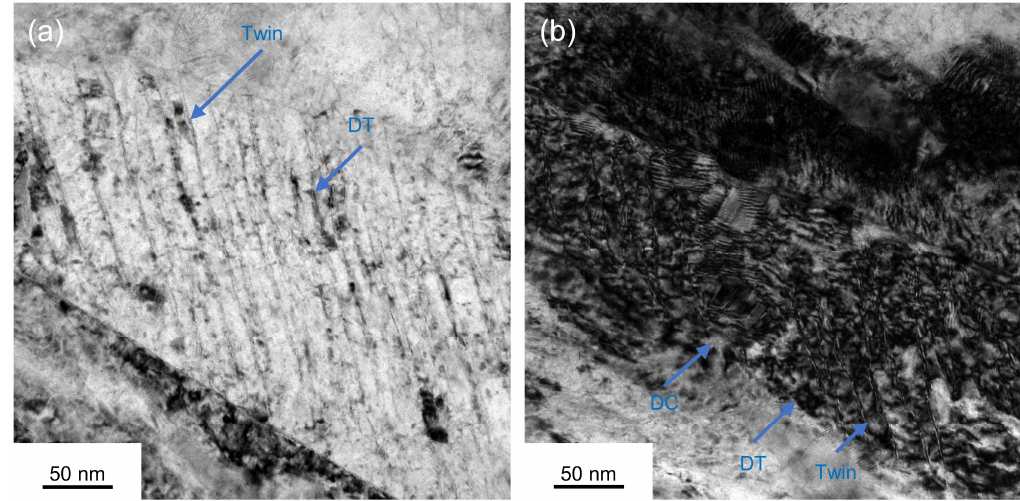
Figure 6. TEM micrographs of the region near the raceway ( P 0 = 5 GPa, N = 1.14 × 10 8 cycles): ( a ) twins with a lower dislocation density; ( b ) twins with a higher dislocation density.